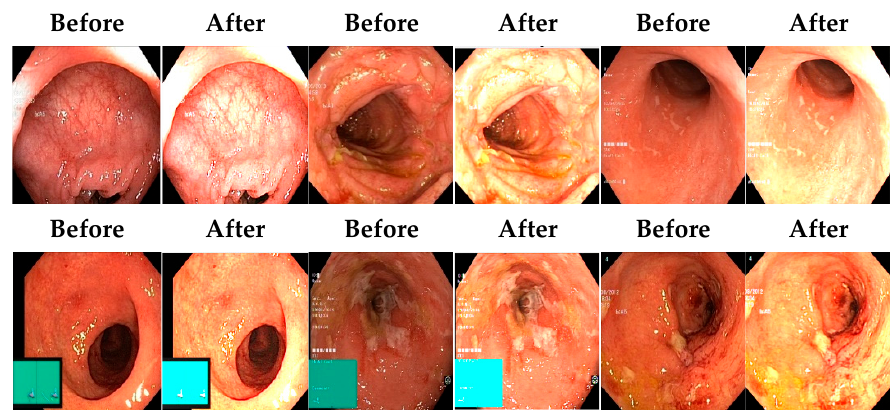
Figure 5. Results after fusing both transformations.